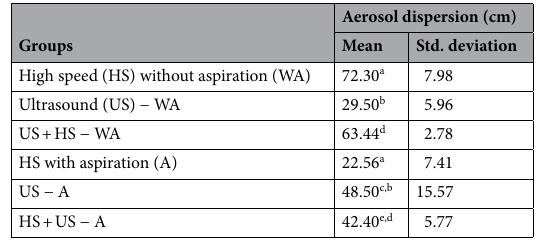
Table 1. The mean and standard deviation values of aerosol dispersion measured in centimeters by the tested groups. Different superscript letters indicate a significant difference between groups (P < 0.05).